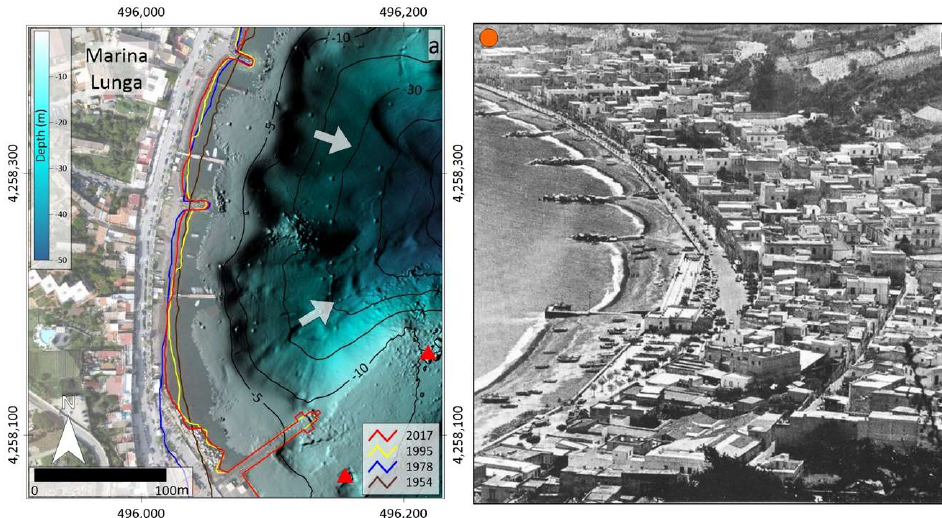
Figure 11. Map of Marina Lunga central-southern sector ( a ) with selected reconstructed shorelines; white arrows show the active canyon heads located in the nearshore. ( b ) Marina Lunga beach after the construction of groynes. See Figure 1 for location.